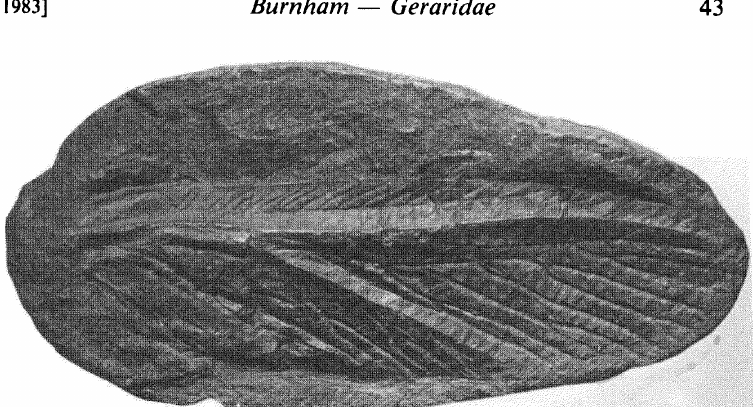
Fig. 25. Nacekomia rossae, photograph of fore wing of holotype no. FMNH PE 791. Length 43 mm.